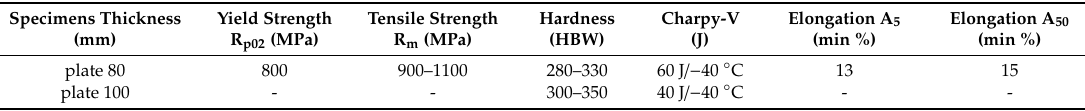
Table 1. Mechanical properties [18,43].